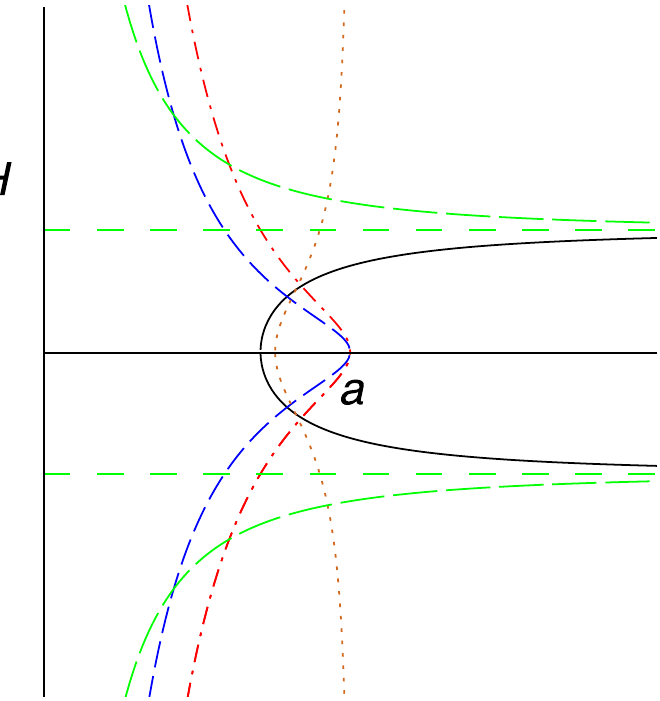
Figure 1. The functions H ( a ) for the problems discussed. The curves correspond, respectively, to the catenary/minimal surface of revolution problems (black, solid); the brachistochrone problem (blue, dashed); the problem of the Poincaré half plane geodesics (red, dash-dotted); the gravity tunnel problem for K = − 1,0 (green, long-dashed) or K = 1 (black, solid); and the terrestrial brachistochrone problem (chocolate,